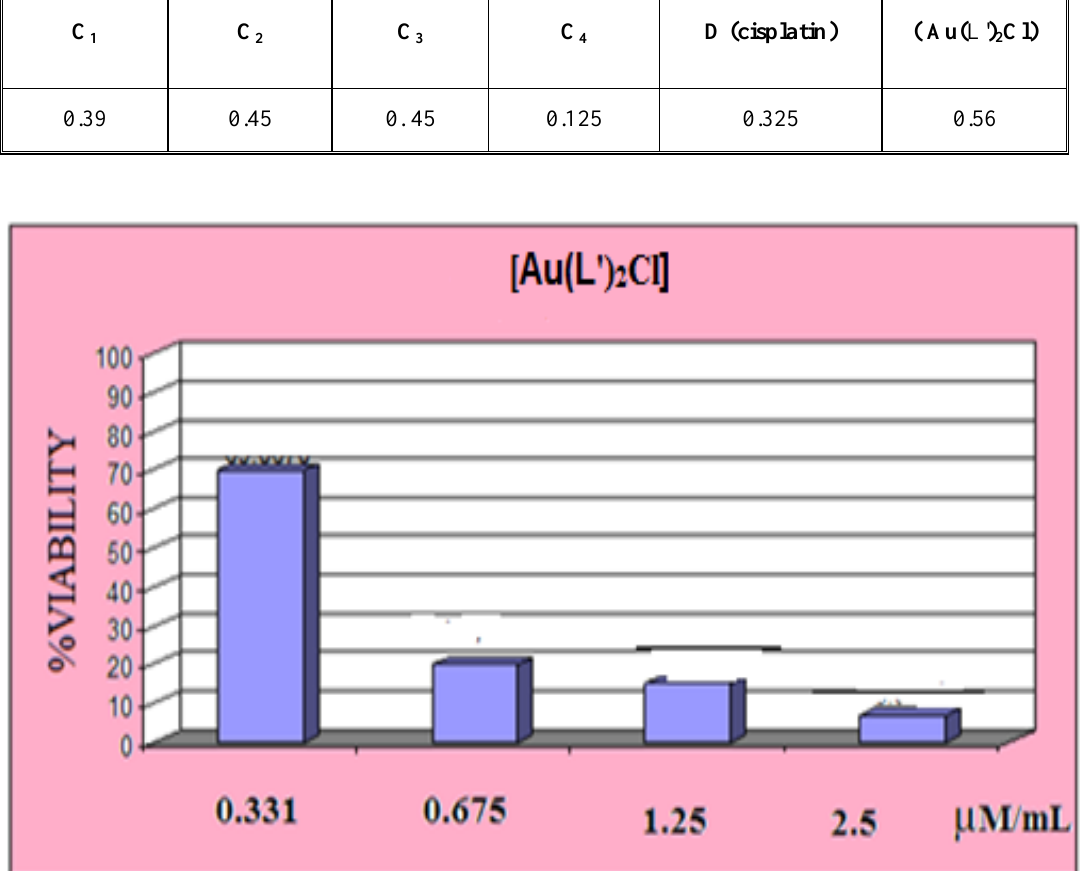
Figure 2: % viability of the[ Au( L' )